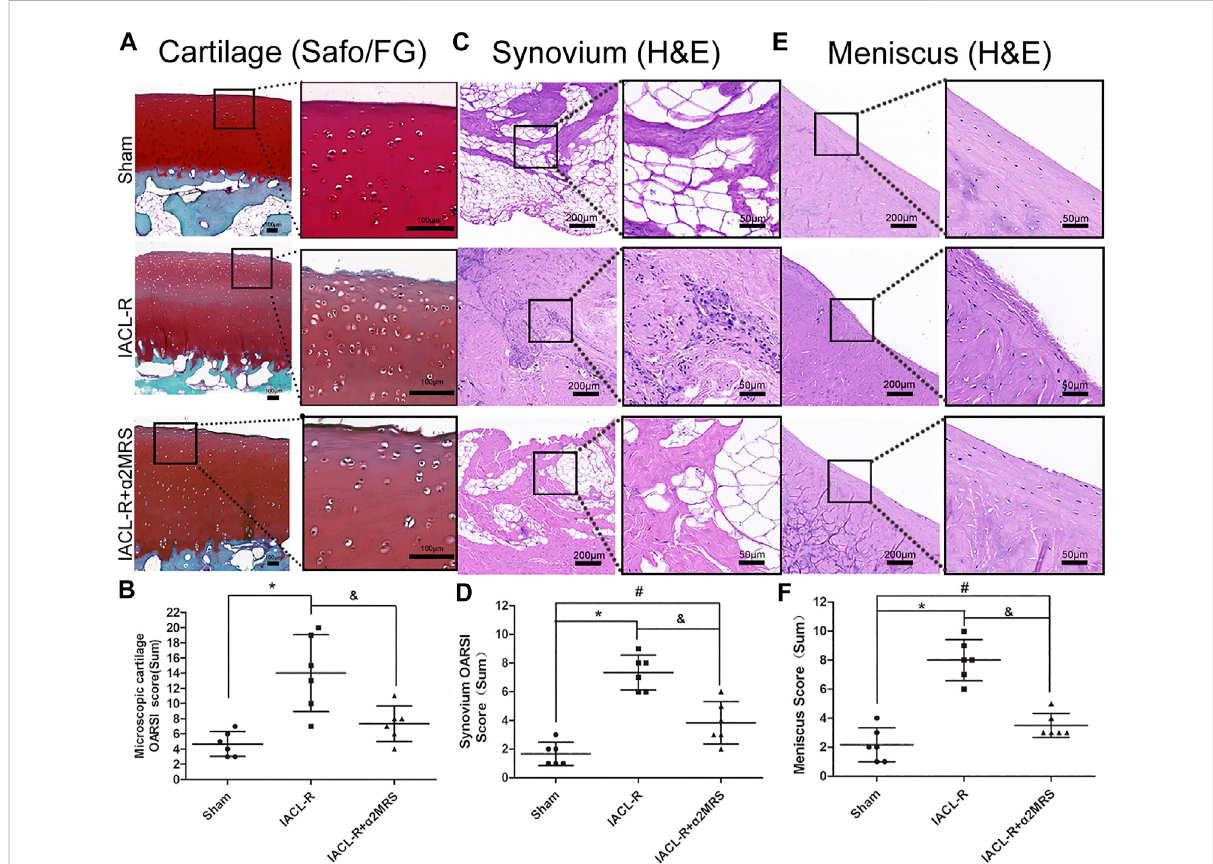
FIGURE 8 (A) ComparedwiththeIACL-Rgroup,lessdecreaseinsafraninOstainingandsurface fi brillationwereobservedintheIACL-R+ α 2MRSgroup. (B) Microscopic cartilage score were lower in the IACL-R+ α 2MRS group than in the IACL-R group ( p = 0.015). (C) On H&E staining of the synovium, we found less degeneration in the IACL-R+ α 2MRS group than in the IACL-R group. (D) Microscopic synovium score were lower in the IACL-R+ α 2MRS groupthanintheIACL-Rgroup( p =0.002). (E) OnH&Estainingofthemeniscus,wefound lessdegenerationintheIACL-R+ α 2MRSgroupthan intheIACL-Rgroup (F) MicroscopicmeniscusscorewerelowerintheIACL-R+ α 2MRSgroupthanintheIACL-Rgroup( p < 0.001).*= p < 0.05,sham groupversusIACL-Rgroup;#= p < 0.05,shamgroupversusIACL-R+ α 2MRSgroup;and= p < 0.05,IACL-RgroupversusIACL-R+ α 2MRSgroup.The bars show the mean ± SD ( n =